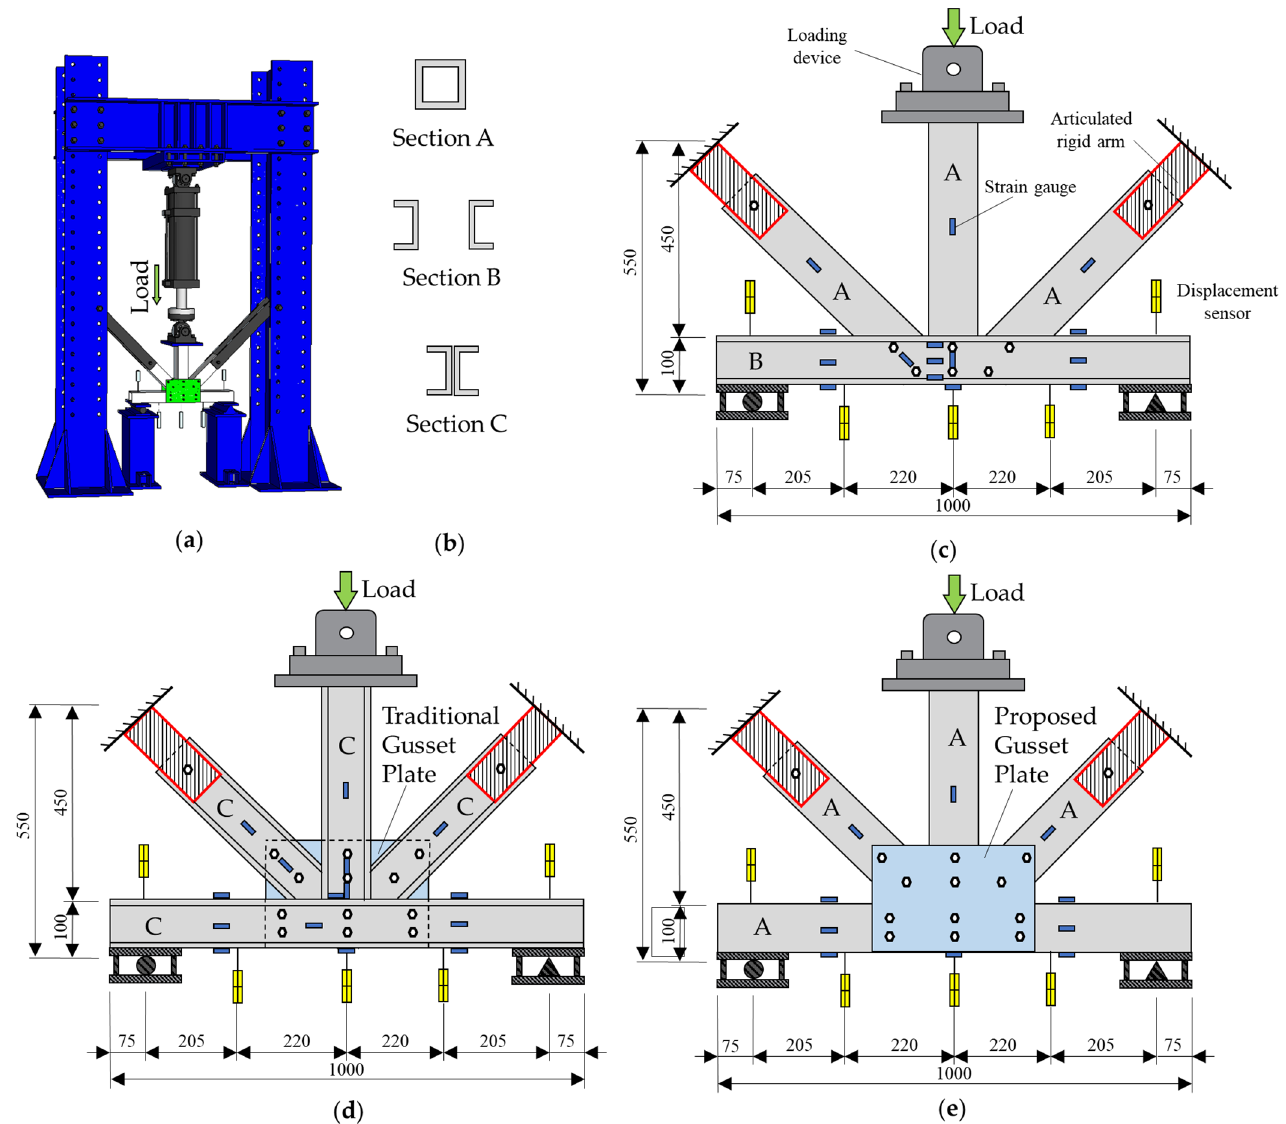
Figure 4. Full-scale test of GFRP truss joint: ( a ) test setup, ( b ) cross sections of members, ( c ) specimen BJ, ( d ) specimen GP, and ( e ) specimen IGP